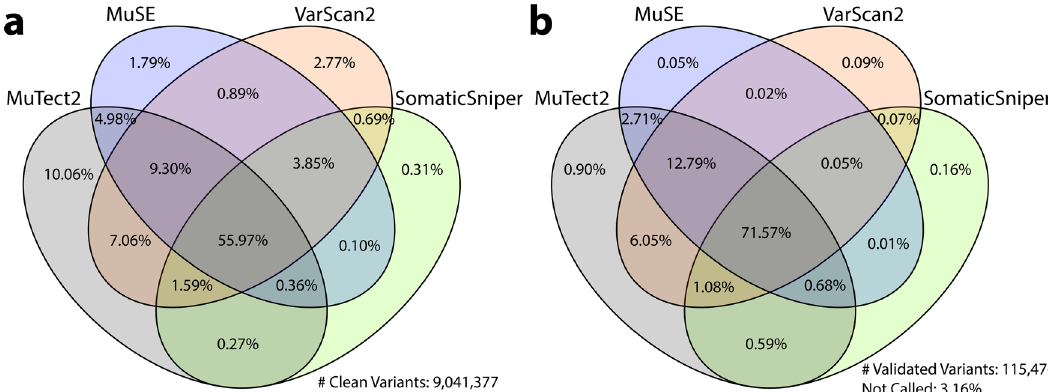
Fig. 2 Comparison of GDC somatic variant caller pipelines. The Venn Diagram on the left ( a ) shows the overlap among four GDC somatic callers. Among all clean variants, 56.0% have been identi fi ed by all four callers, 15.1% by three callers, 14.0% by two callers, and 14.9% by only one caller. The Venn Diagram on the right ( b ) shows recall rate of validated TCGA variants by GDC somatic callers. Among 115,476 TCGA validated variants collected, 3.2% are not recalled by any of the GDC pipelines; 1.2% are recalled by only one pipeline; 9.4% are recalled by two pipelines; 14.6% are recalled by three pipelines; and 71.6% are recalled by all four GDC